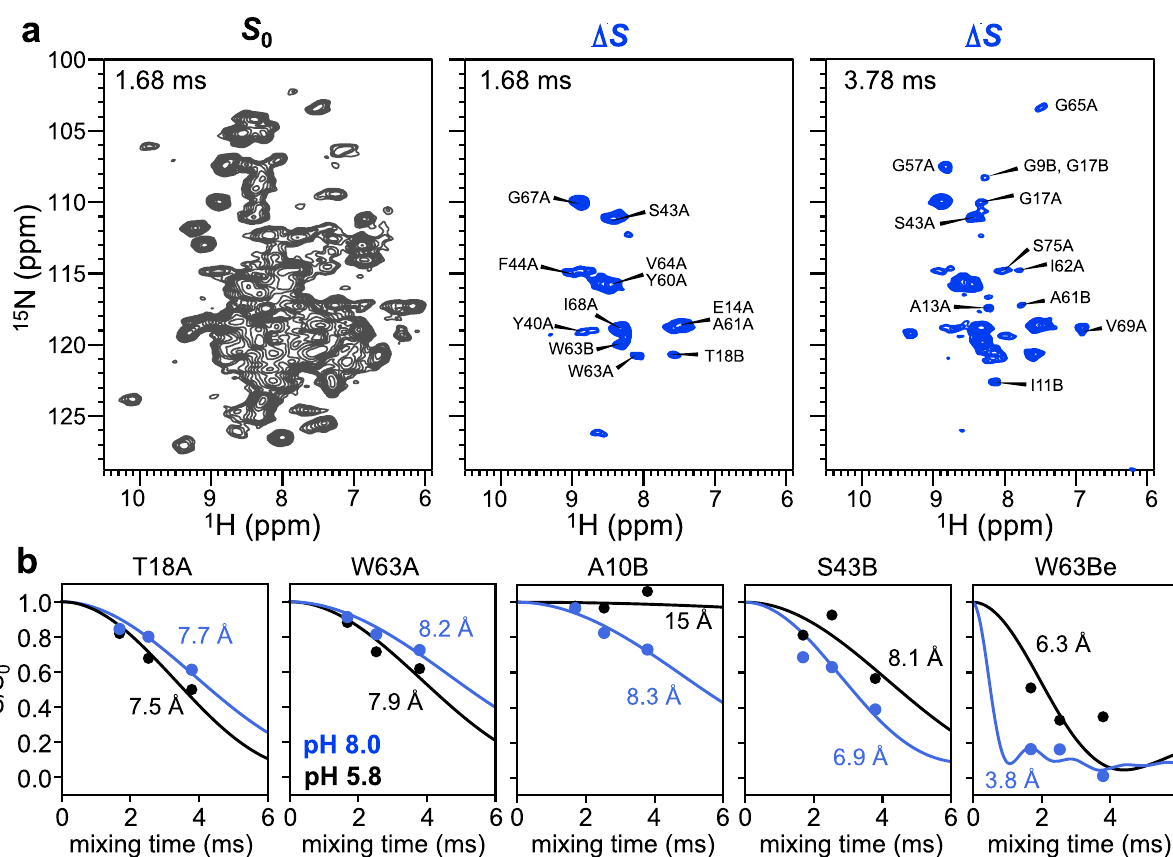
Fig. 3 1 H – 19 F distance measurements between EmrE H N and F 4 -TPP + using 2D-hNH resolved 1 H – 19 F REDOR. a Representative S 0 (black) and Δ S (blue) spectra for two mixing times, 1.68 and 3.78 ms. Assignment is shown for peaks in the Δ S spectrum. As the mixing time increases, more difference peaks are observed, corresponding to H N sites that are further from the fl uorinated substrate. b Representative 1 H – 19 F REDOR S / S 0 dephasing curves with best- fi t simulations. 1 H – 19 F distances at pH 8.0 (blue) differ from the pH 5.8 data (black). The indole H N of W63B has much shorter distances to the substrate fl uorines at pH 8.0 than at pH 5.8. REDOR dephasing values are provided as a Source Data fi